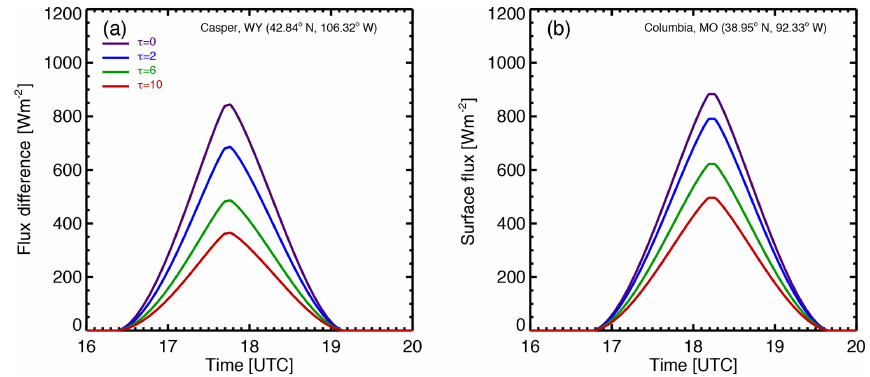
Figure 9. (a) Casper; (b) Columbia. The modeled surface SW flux reduction ( F non-eclipse,model − F eclipse,model ) for eclipse (solid lines) and non-eclipse conditions for different cloud optical depths.